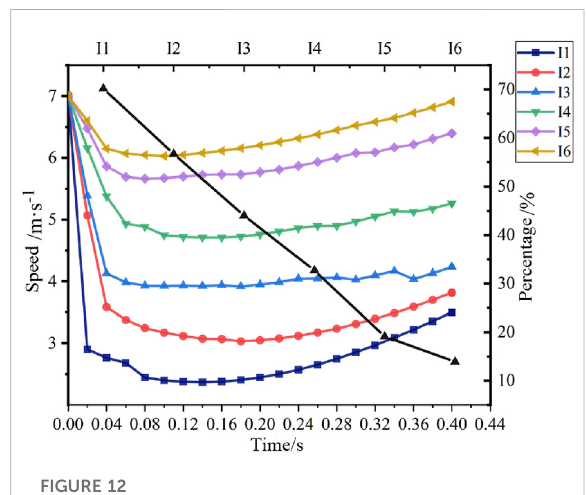
FIGURE 12 Rolling stones speed variation curve under impacting stones with different